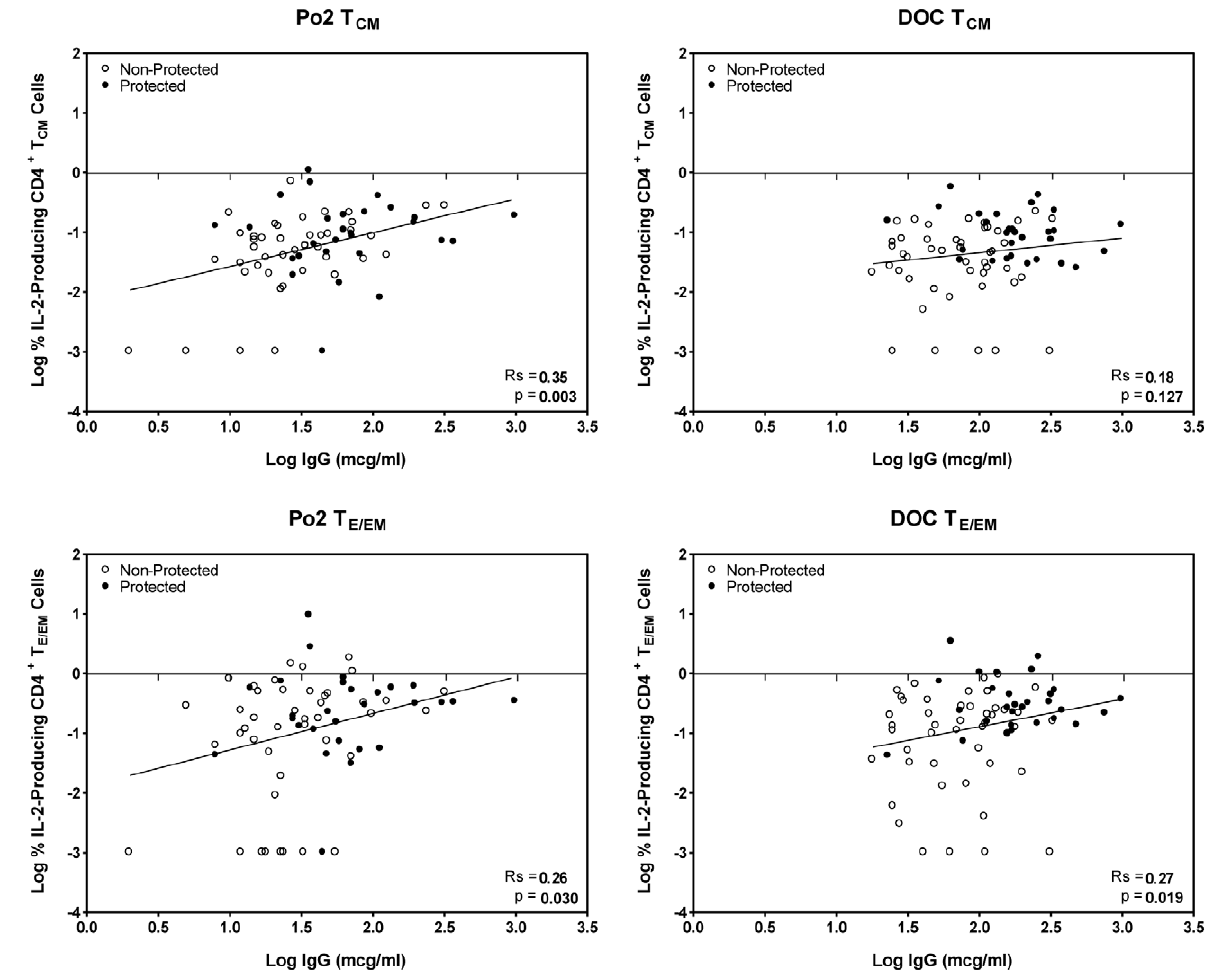
Figure 7. CSP-specific IL-2 + T E/EM and T CM CD4 + T cells correlate with anti-CSP R region Ab titers. The figures display the log base 10 of the IgG level in micrograms per milliliter versus log of the percent of T cells expressing IL-2 as assayed by flow cytometry. Individuals who were protected from malaria by vaccination are noted with filled circles, while those not protected by open circles. The figure also shows the Spearman’s correlation between the log IgG and log percent cells for the combined protected and non-protected individuals as well as a trend line.